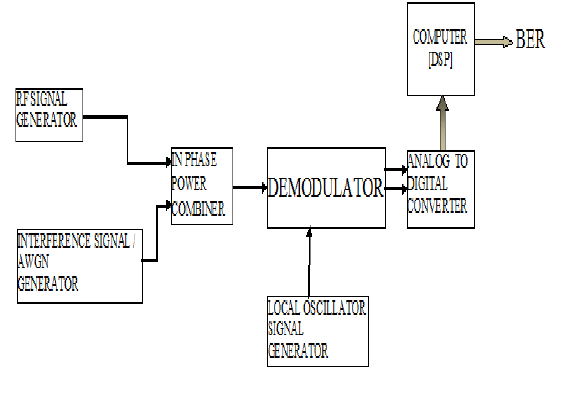
Figure 6: Test-bench utilized for experimental measurement of BER Figure 7 p resents t he co mparison o f t he p erformance o f classical DCR with our proposed method in static condition with AWGN. H ere co mparison h as b een d one with t he theoretical B ER for Q PSK s ystem with simulated a nd measured BER of classical DCR architecture and proposed method. A t B ER = 10 -3 , th e i mplementation lo ss for proposed D CR a rchitecture is e qual t o 0. 8dB, w hile for classical DCR it is approximately 2dB.